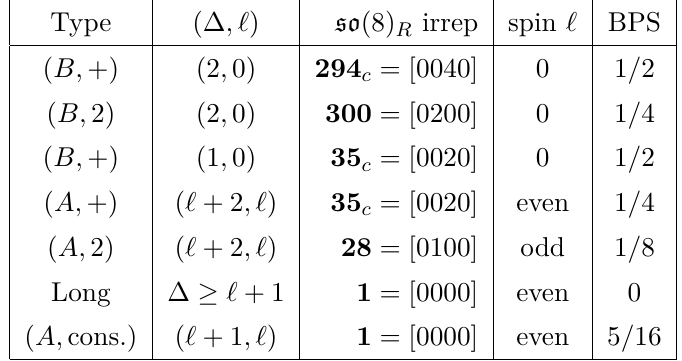
Table 13 . The possible superconformal multiplets in the S × S OPE. The so (3 , 2) ⊕ so (8) R quantum numbers are those of the superconformal primary in each